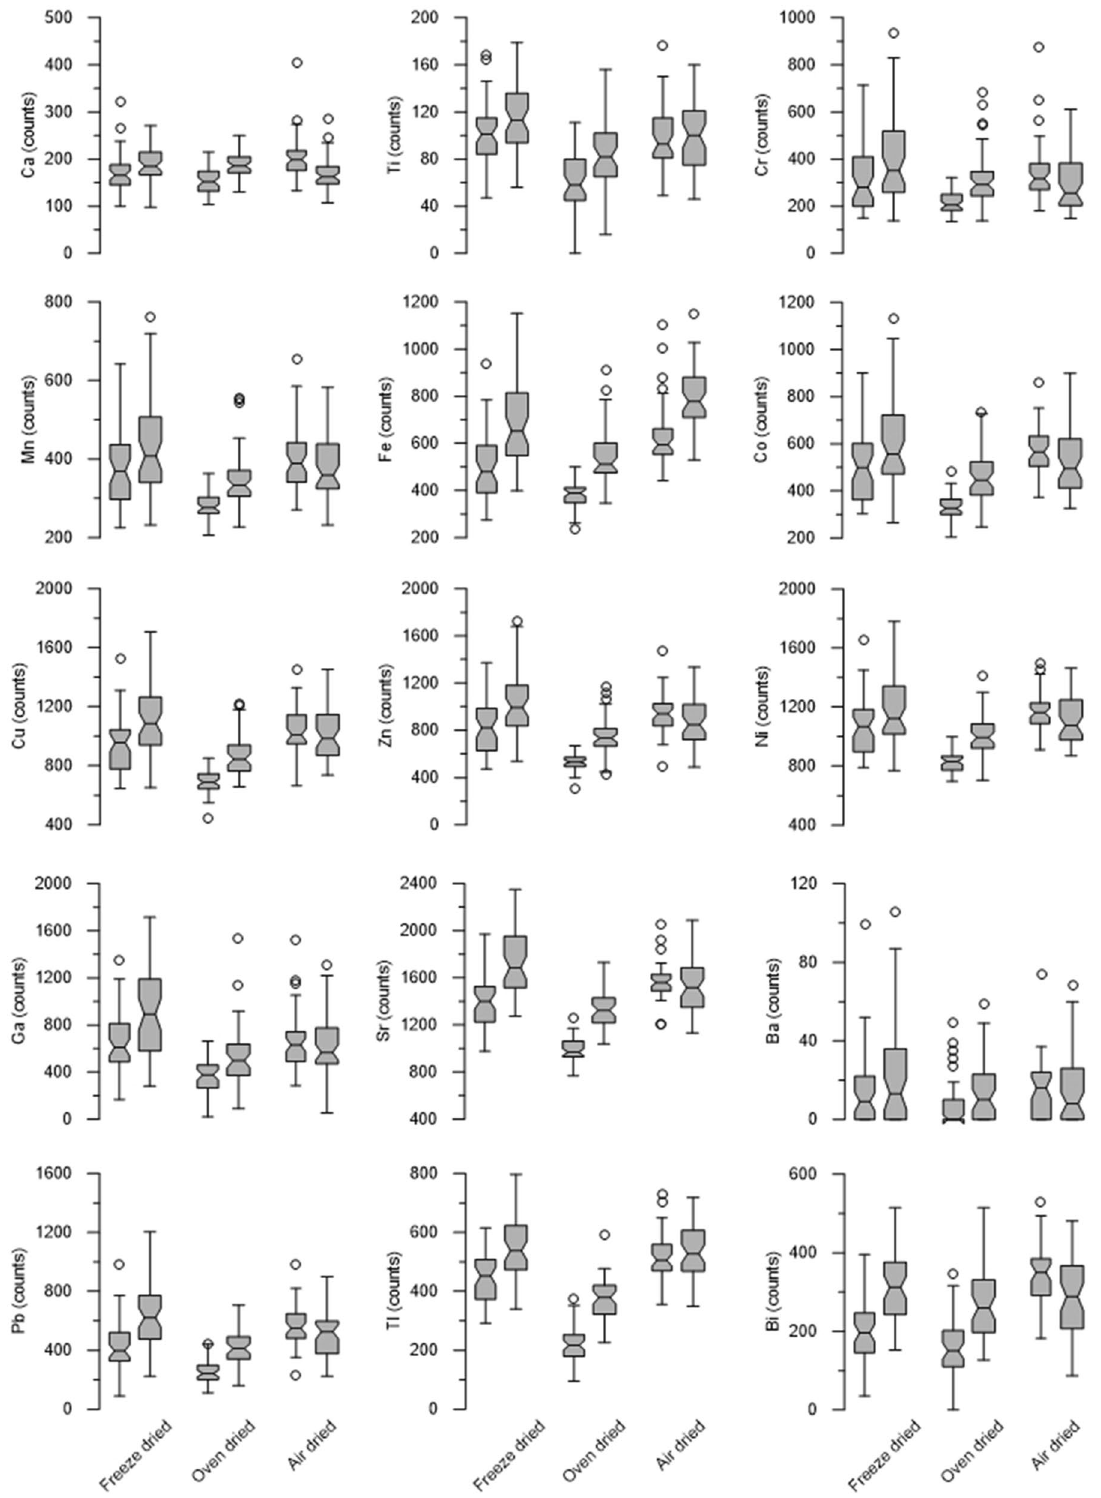
Figure 4. Box plots showing the measured element counts of the three drying methods for the fifteen relevant elements in the test solution. Generally, freeze dried samples show higher counts, while the oven dried samples display a smaller variance in most element